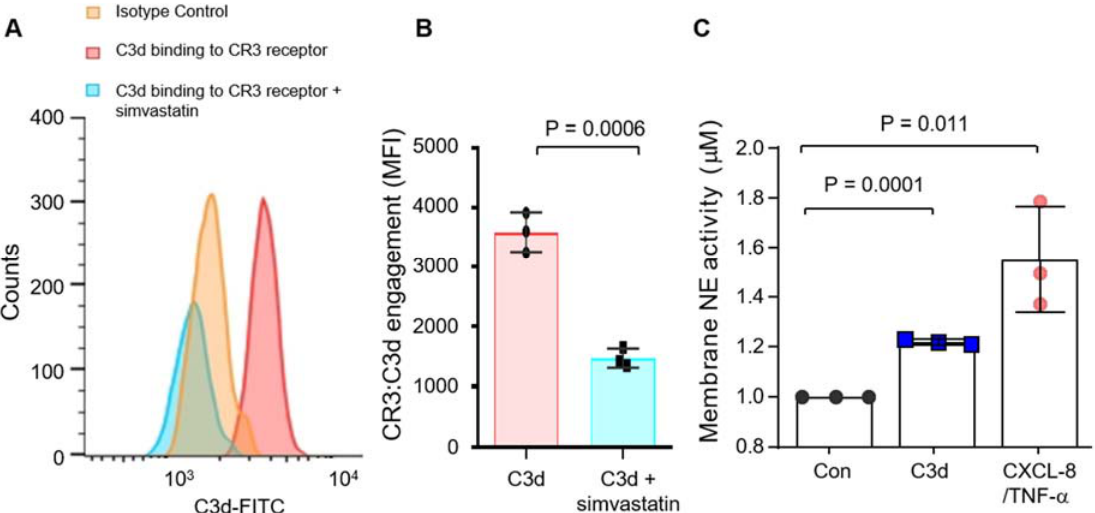
Figure 3. C3d binds neutrophil CR3 and causes the release of neutrophil elastase. ( A ) Flow cytometry analysis of C3d bound to the CR3 membrane receptor on isolated HC neutrophils (red), and in the presence of the CR3 blocker, simvastatin (1 mM). C3d (5 µ g) binding was evaluated using C3d mouse monoclonal IgG1. ( B ) The level of CR3/C3d binding was found to be reduced by the inclusion of simvastatin (Student t ‐ test). ( C ) NE activity was significantly higher on membranes of C3d or CXCL8/TNF ‐α challenged neutrophils compared to unstimulated cells (Con) ( P = 0.0001, n = 3 biological repeats, Mann–Whitney U test).